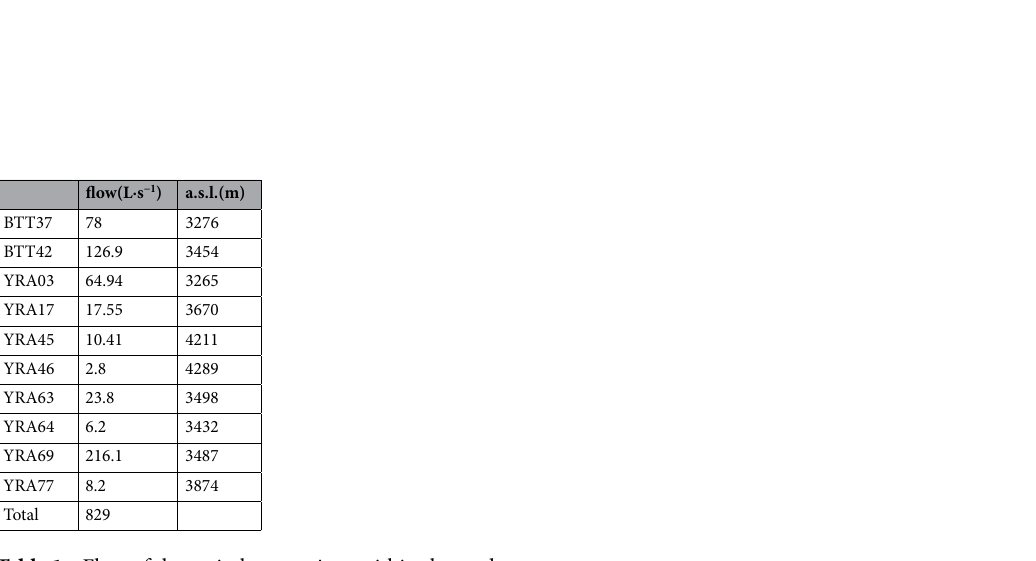
Table 1. Flow of the main karst springs within the study